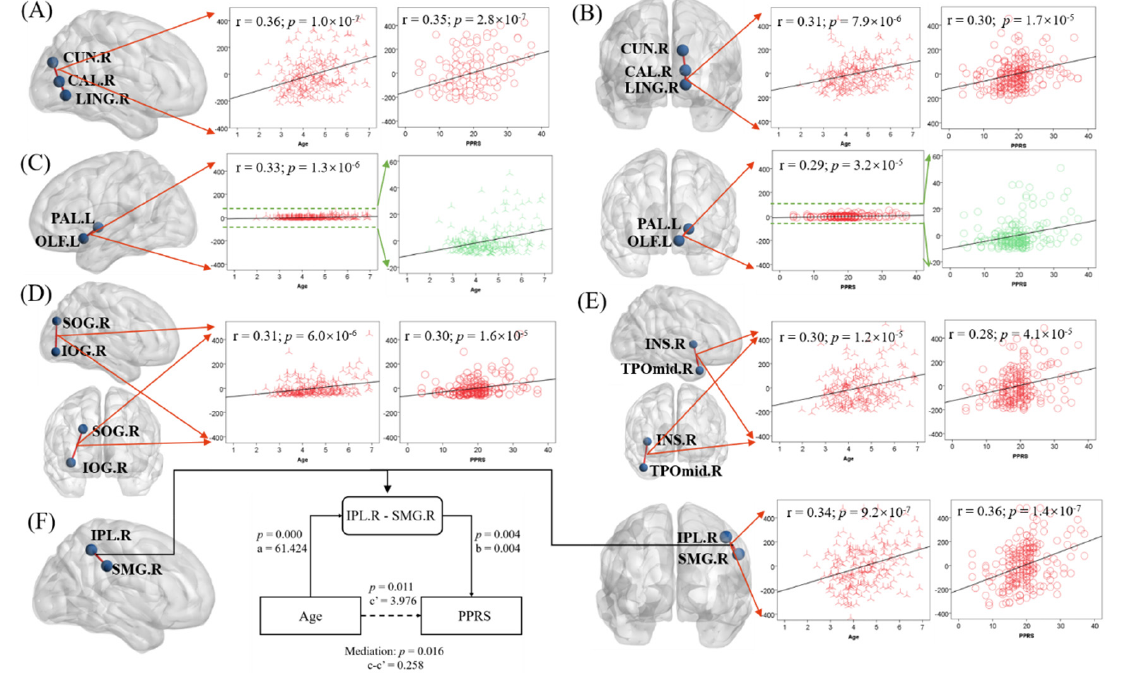
Figure 5. Linear regression of the fiber connection number in six pairs of regions (( A ) CUN.R and CAL.R; ( B ) CAL.R and LING.R; ( C ) PAL.R and OLF.L; ( D ) SOG.R and IOG.R; ( E ) INS.R and TPOmid.R; ( F ) IPL.R and SMG.R) with age ( B ) and PPRS ( C )). F also shows the results of the mediation analysis when the hypothetical model is Age → IPL. R-SMG.R → PPRS. Note that the scatter plots show the r and p , after age, sex, maternal education, and handedness had been accounted for.